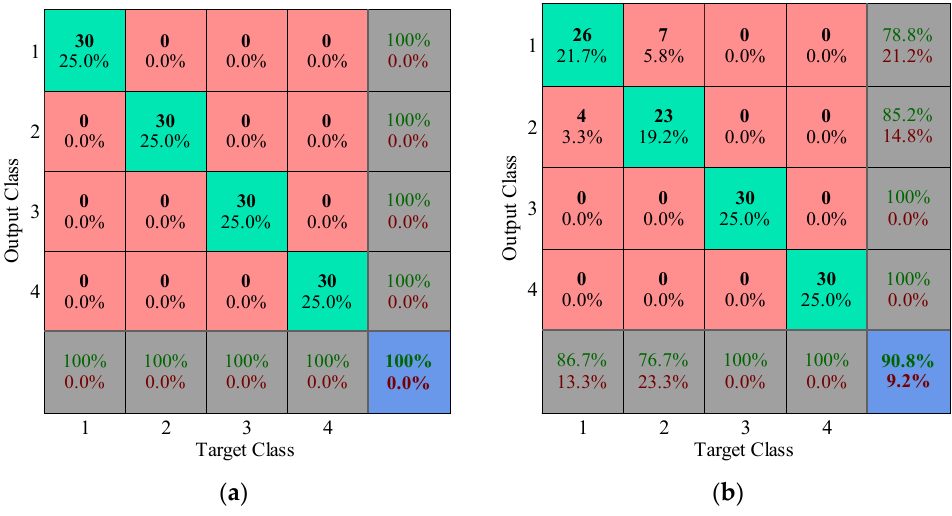
Figure 12. Multi-class confusion matrices of testing samples: ( a ) Dictionary learning pre-processor; ( b ) EMD pre-processor.